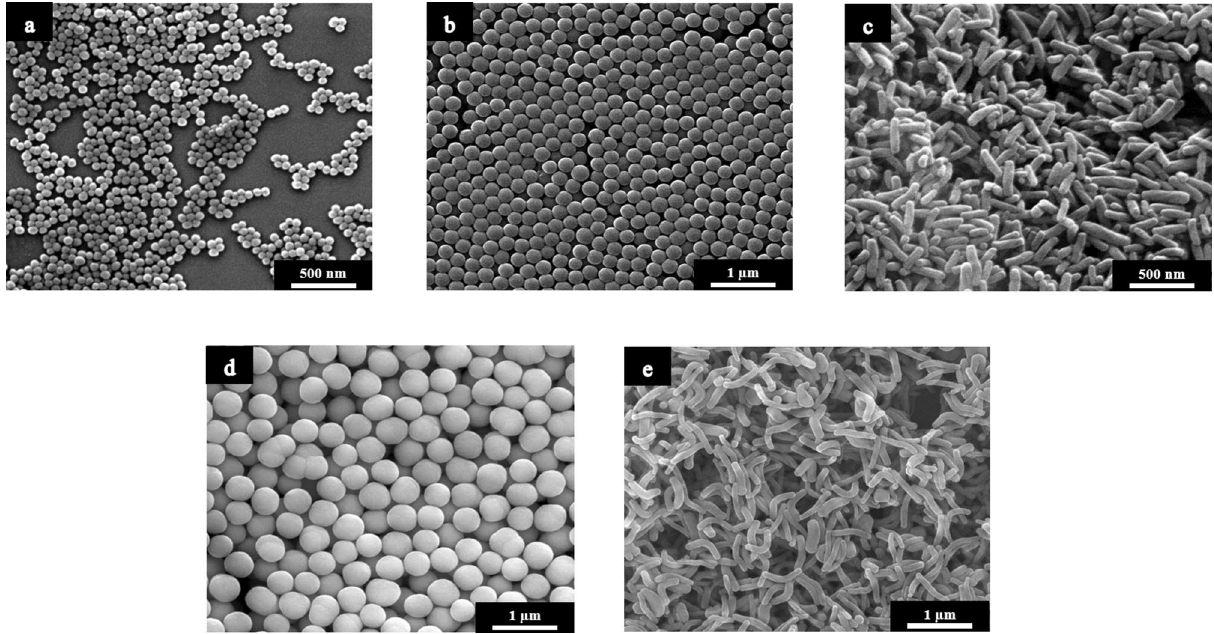
Figure 1. SEM images of unfunctionalized silica particles: Nanospheres ( a ), submicrospheres ( b ), submicrorods ( c ), microspheres ( d ), microrods ( e